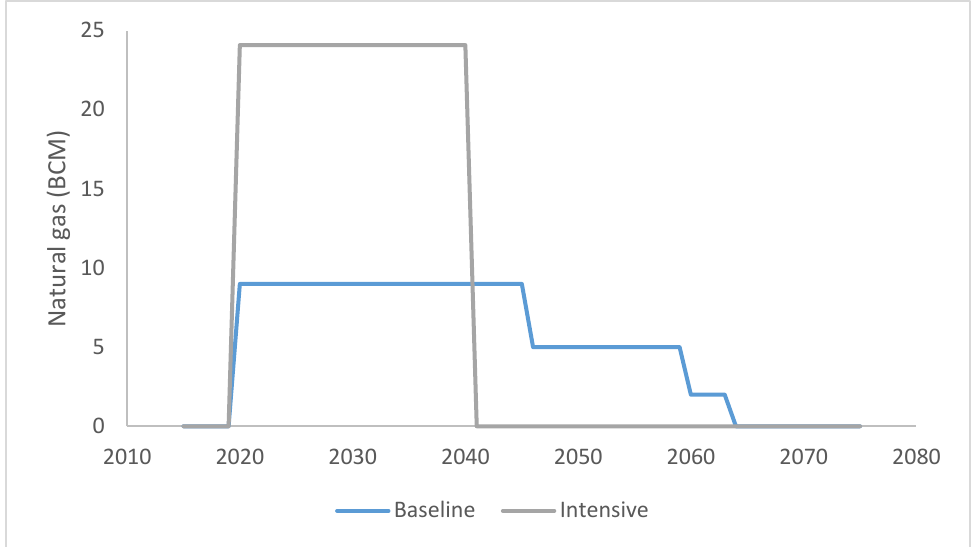
Figure 2. Natural gas (NG) export amounts for the baseline and intensive scenarios.